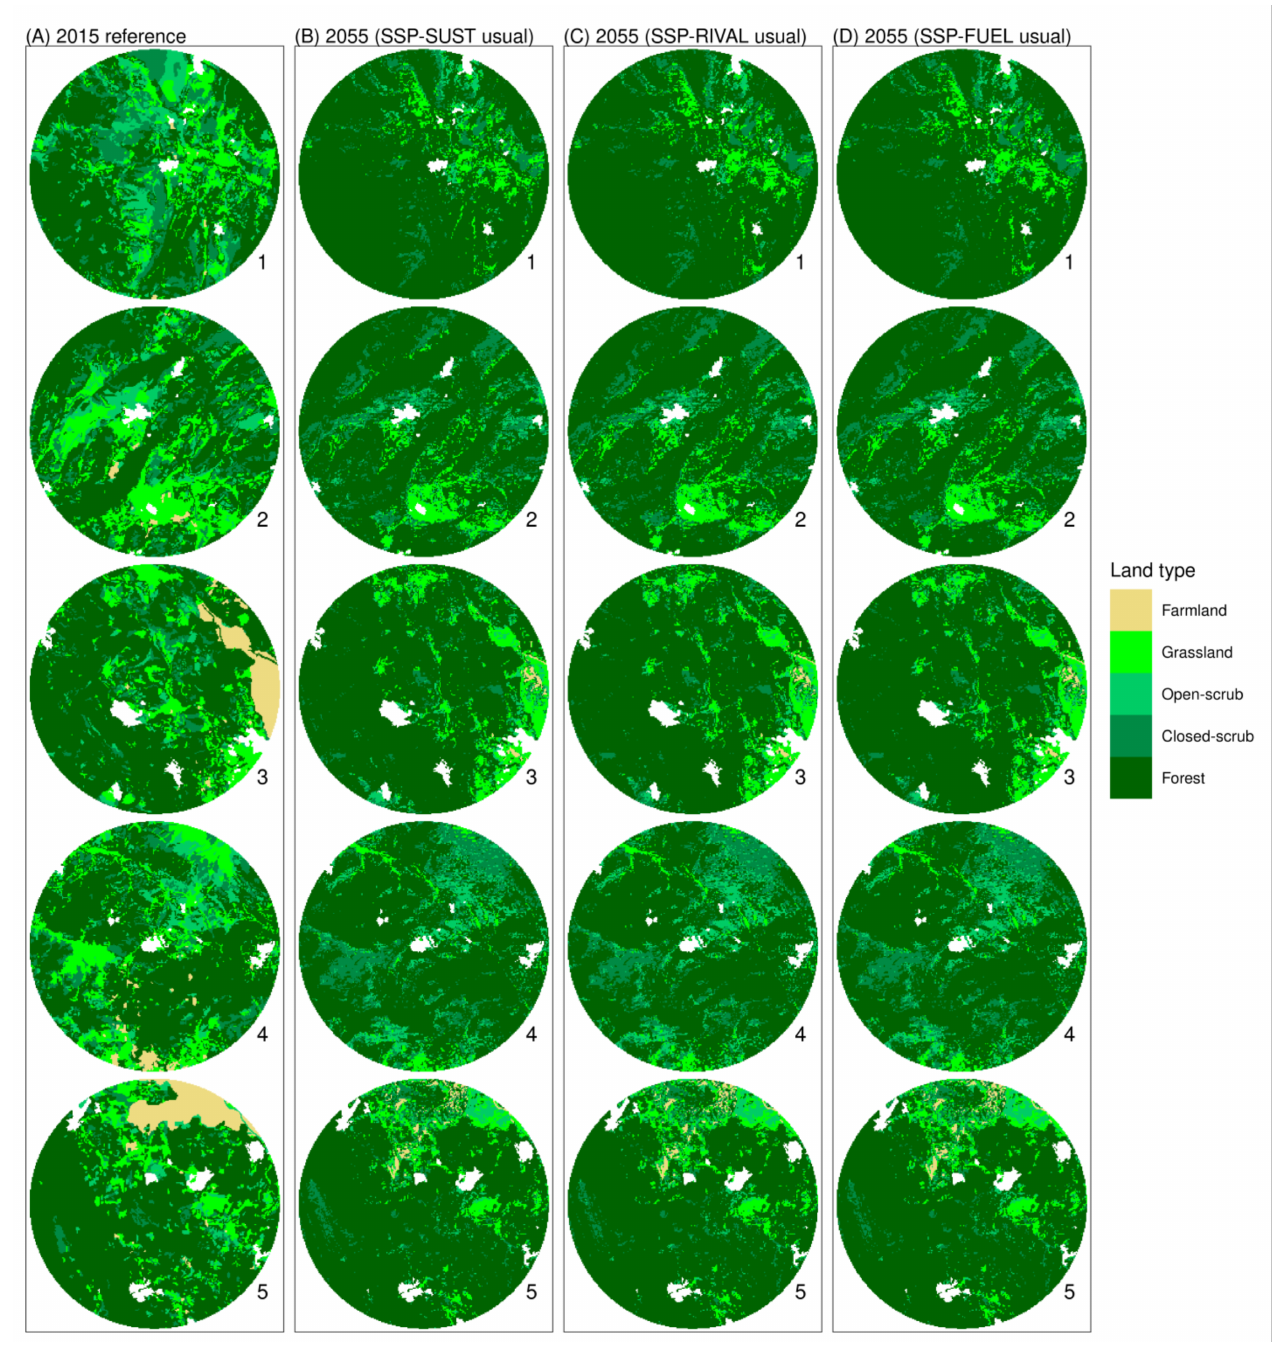
Figure 6. Future LUC predictions for the three climatic scenarios under the business-as-usual demand scenario. For reference, we provide the map of the year 2015 ( A ). The three climatic scenarios were the SSP-SUST ( B ), SSP-RIVAL ( C ) and SSP-FUEL ( D ), from the most to the least optimistic one. The five study sites of 6 km diameter are numbered as in Figure 1, maintaining the same orientation vertically towards